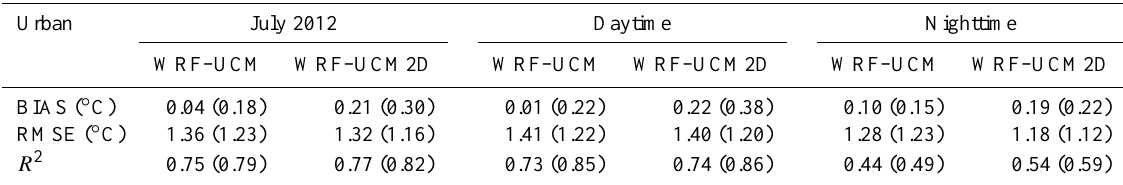
Table 4. Bias, RMSE, and R 2 calculated using simulated temperatures at 19 urban stations for the month of July 2012, for daytime, and for nighttime obtained by WRF–UCM and WRF–UCM2D. The numbers in parentheses were analysis results after the exclusion of model data where simulated rainfall was found to be present.